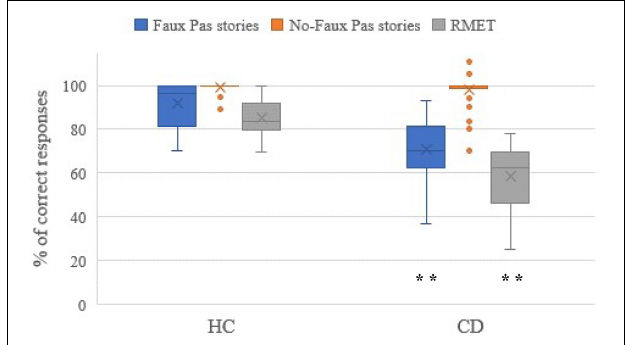
FIGURE 1 | The scores of the social cognition battery. Data are presented as the percentage of the total number of correct responses for the Faux Pas stories (max = 60) and the No-Faux Pas stories (max = 20), and for the RMET (max = 36). The mean scores of the accuracy percentage, where 0% is totally wrong and 100% is totally correct, are reported for the CD and HC groups, and significant differences of p < 0.01 are indicated by ∗∗